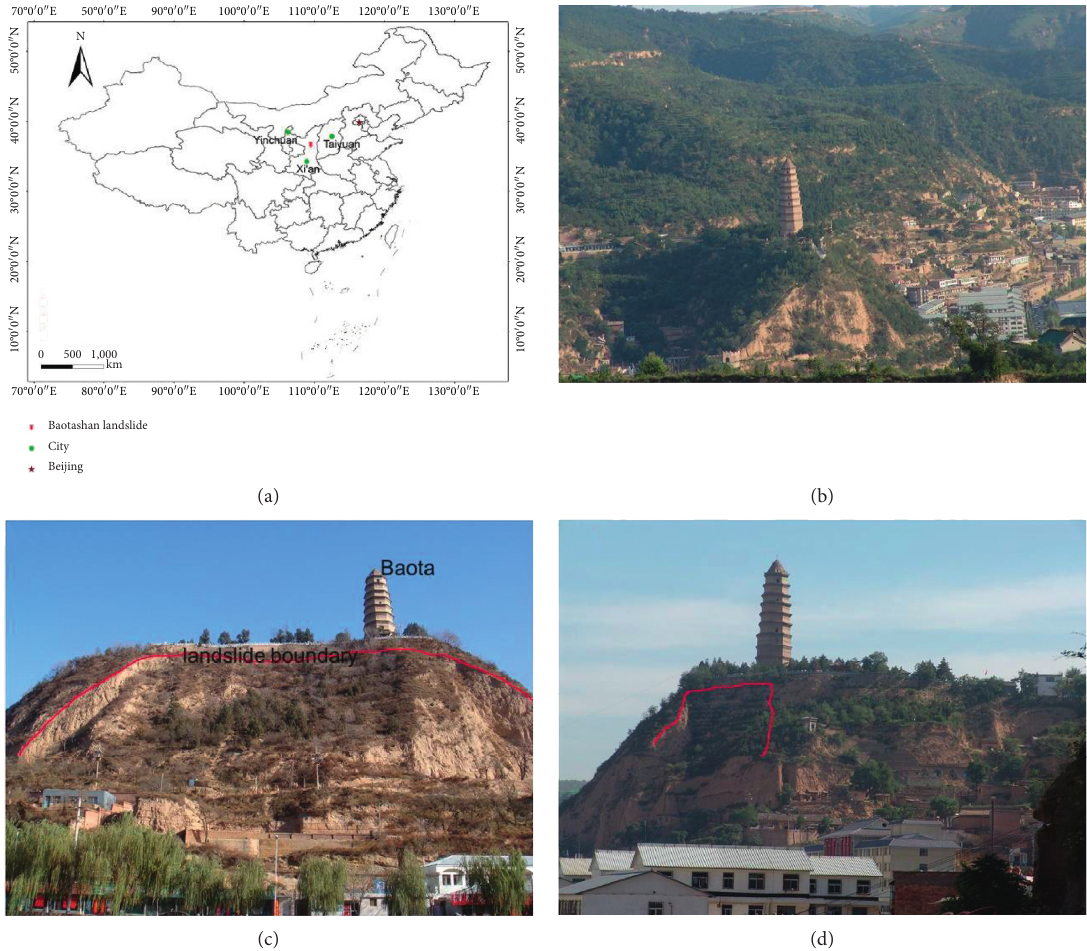
Figure 1: Study area: (a) location of the landslide in China; (b) landslide panorama; (c) landslide No. 1; (d) landslide No.